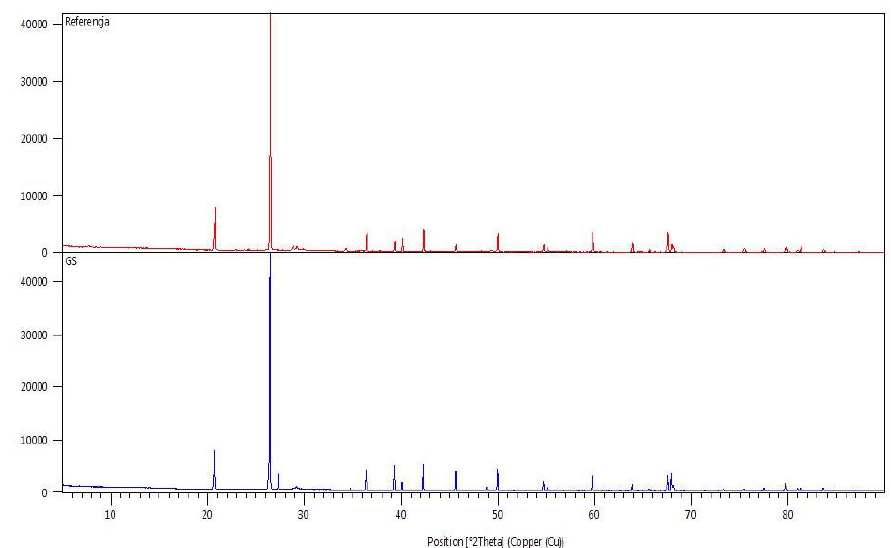
Figure 26. Samples (reference and modified by GS) after 36 months (crystallization).